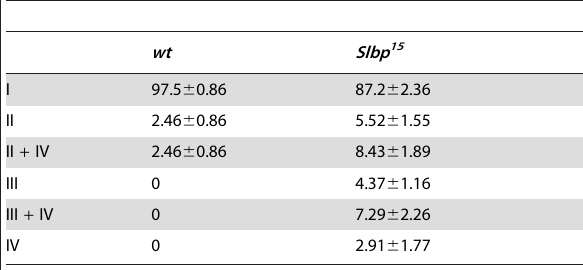
Table 1. Mean Percentage of Mitotic Nuclei Per Brain in Each